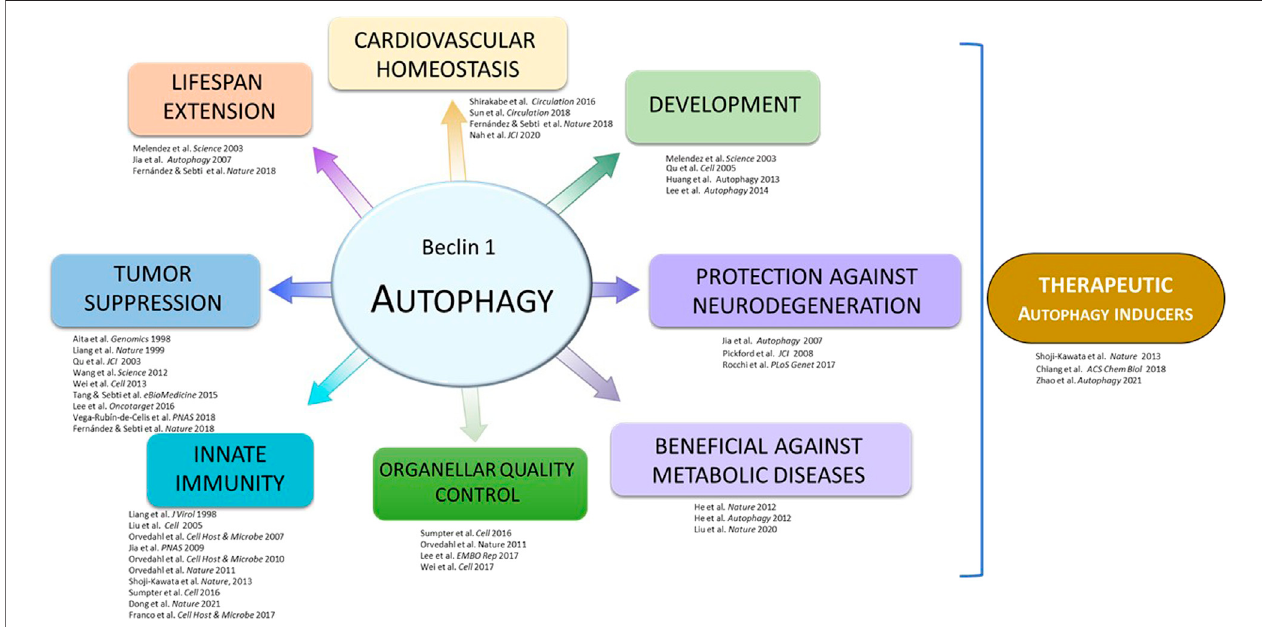
FIGURE 1 | Outline of discoveries from the Beth Levine laboratory.